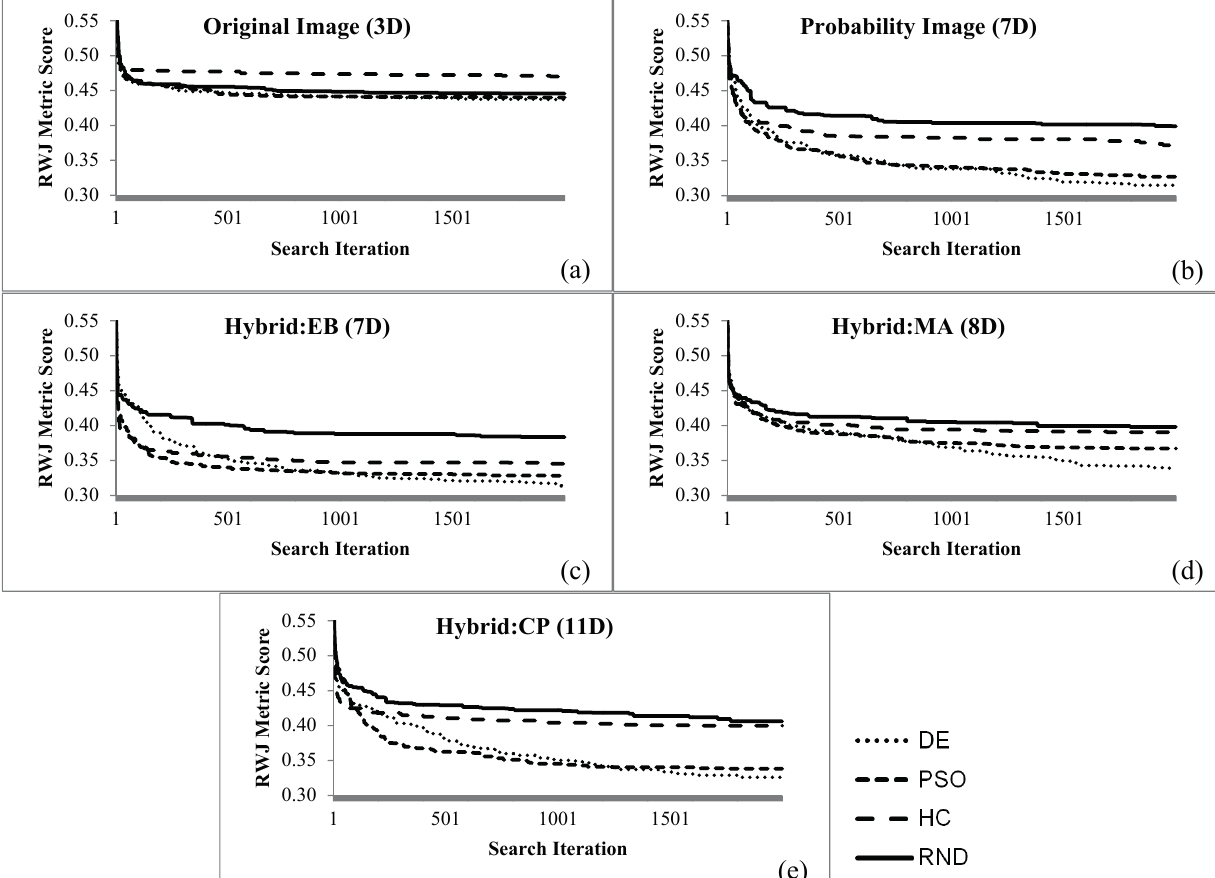
Figure 20. Fitness traces using different search methods for the Hagadera problem instance. Each subfigure shows results using a different method variant.